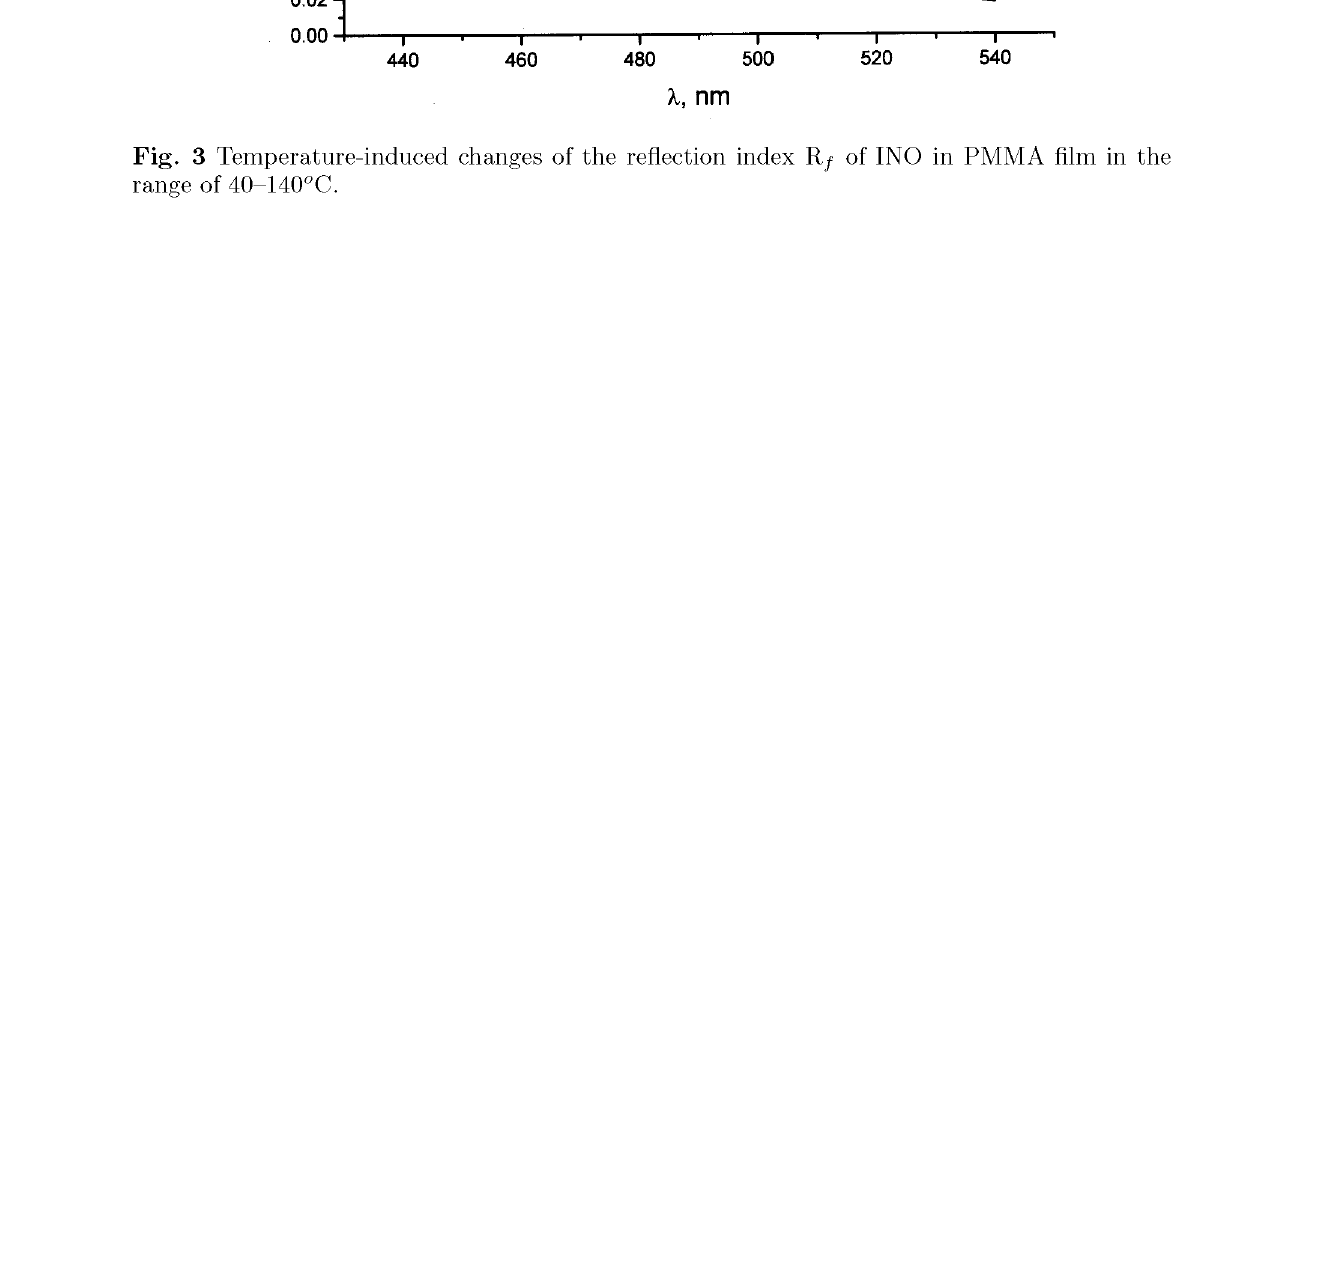
Fig. 3 Temperature-induced changes of the reflection index R/ of INO in PMMA film in the range of 40